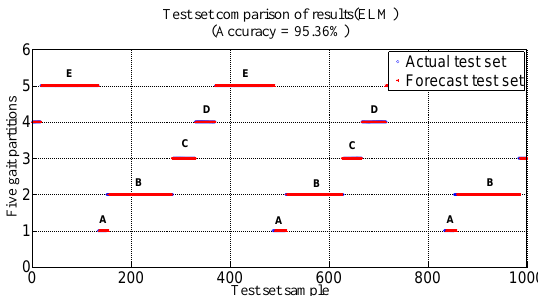
Figure 6. Gait phase classified by plantar pressure datas. Stages A, B, C, D, and E correspond to the stages divided in Figure 5. ABCD are the states of the stance phase; E is the state of the swing phase. The heel touches the ground only in stage A, and the hallux touches only in stage D, so A is considered to be the phase pre-conversion stage from the swing phase to the stance phase, and D is the phase pre-conversion stage from the stance phase to the swing phase. The phase smoothing switching strategy is performed in these two stages, which is described later.